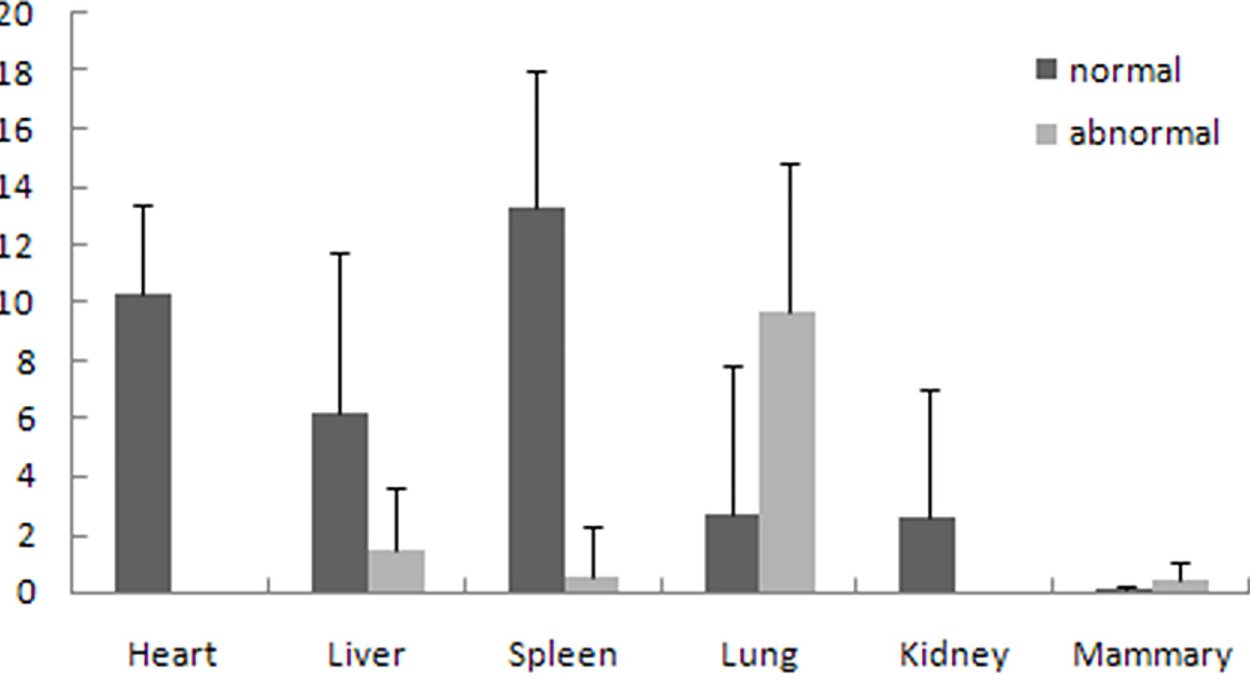
Fig 4. C3 expression in different tissues of healthy cow samples and diseased